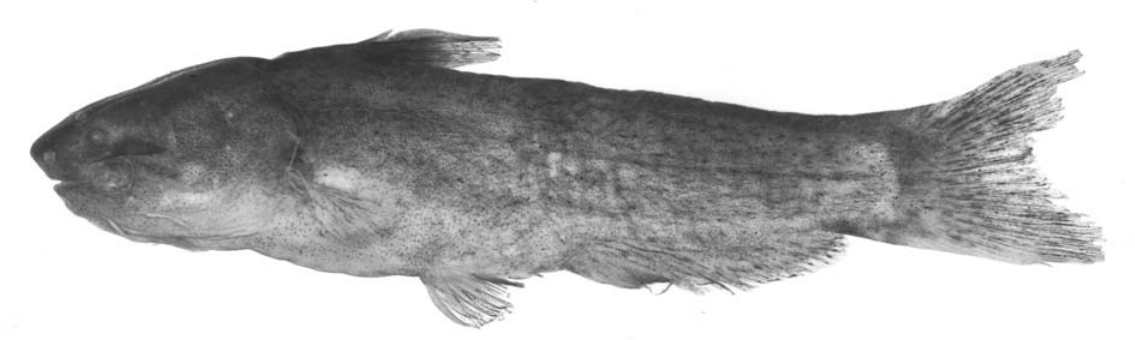
Fig. 50 . Denticetopsis praecox , paratype of Pseudocetopsis praecox, AMNH 74445, 46 mm SL; Venezuela, Amazonas, río Baria, above Neblina base